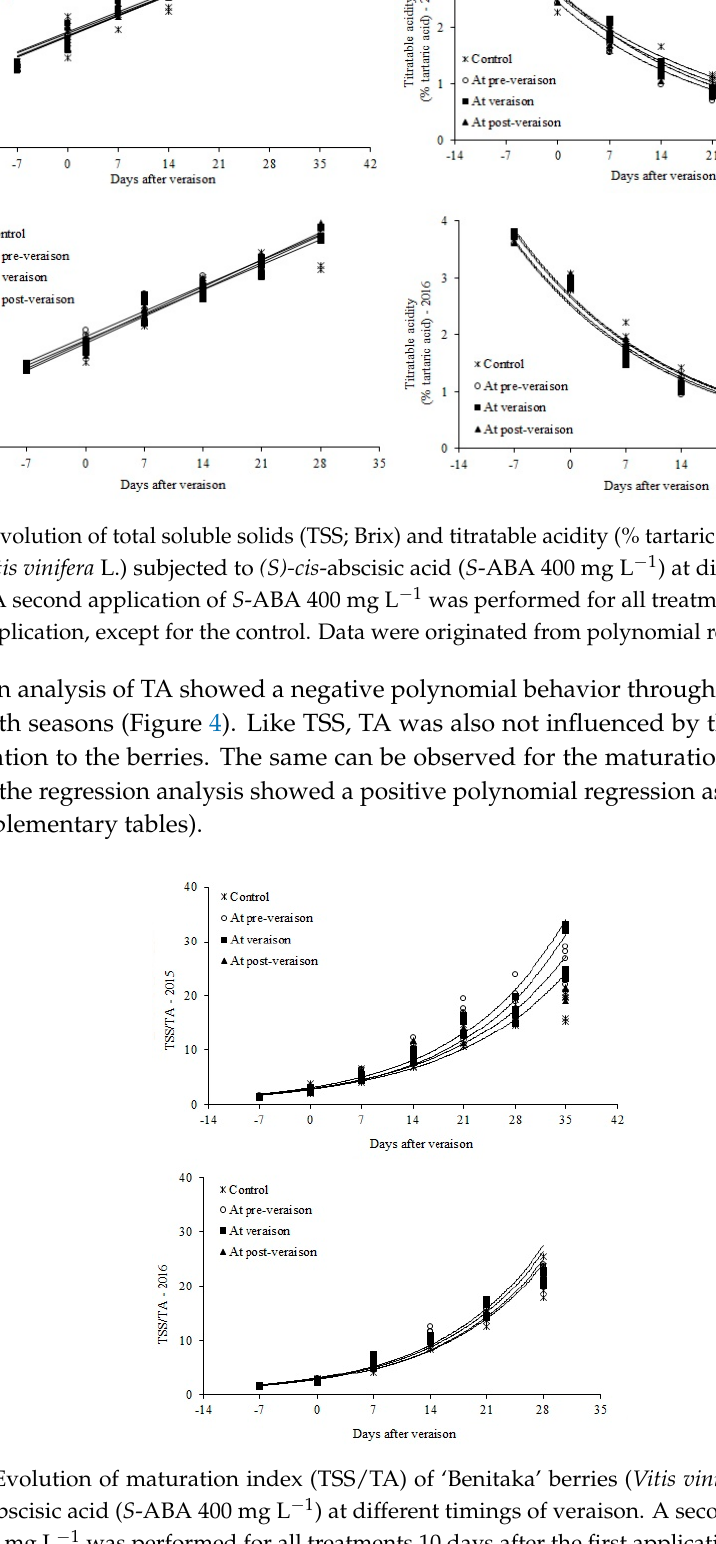
Figure 3. Berries of ‘Benitaka’ table grapes subjected to different treatments with ( S )- cis -abscisic acid ( S -ABA 400 mg L − 1 ). A: control (no application); B: at pre-veraison; C: at veraison; D: at post-veraison. A second application of S -ABA 400 mg L − 1 was performed for all treatments 10 days after the first application, except for the control.